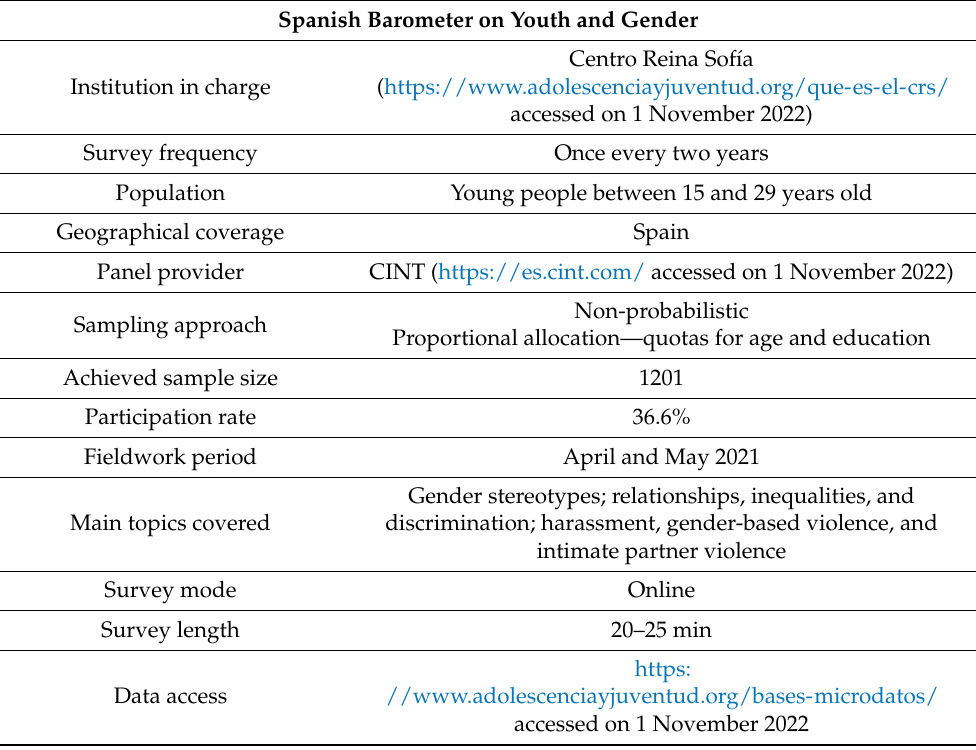
Table A1. Information about the 2021 Barometer on Youth and